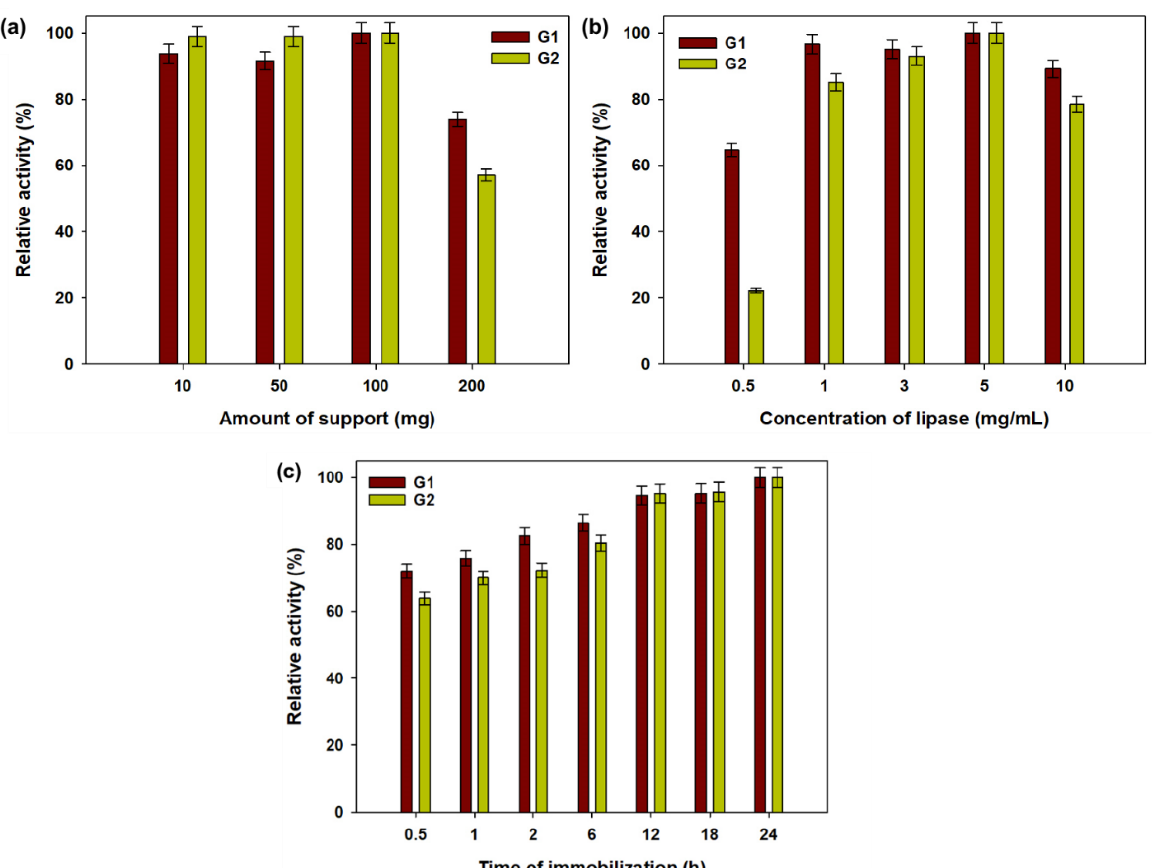
Figure 5. Relative activity of the immobilized enzymes depending on ( a ) amount of support, ( b ) concentration of protein, and ( c ) time of the immobilization process. All data are presented as the means ± standard deviation of three experiments.